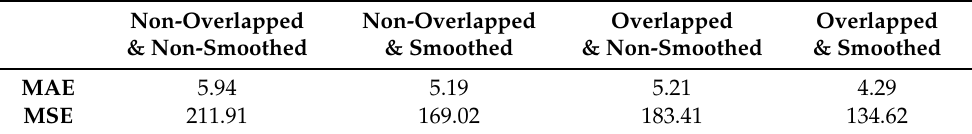
Table 2. Evaluation of data preprocessing steps, based on the vanilla AE model (one hidden layer). Non-Overlapped